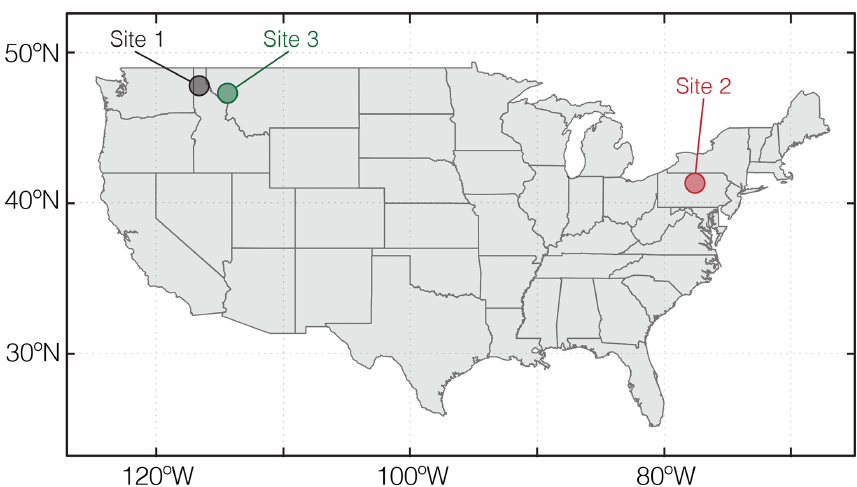
Figure 5. Locations of natural weathering sites whose boundary conditions are tabulated in Table 8 and utilized for example simulations in Sect. 3.